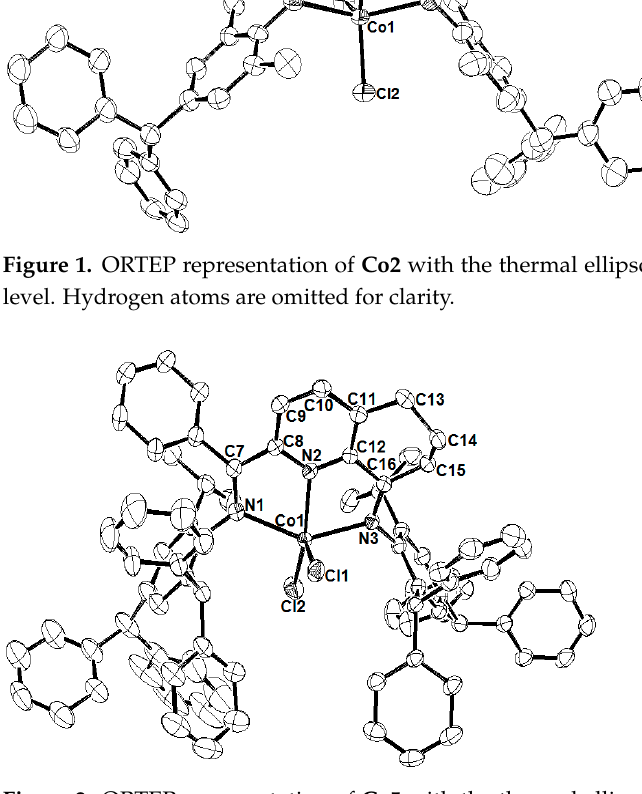
Figure 2. ORTEP representation of Co5 with the thermal ellipsoids shown at the 30% probability level. One molecule of Co5 and hydrogen atoms are omitted for clarity. Table 1. Selected bond lengths (Å) and angles (°) for Co2 and Co5 .